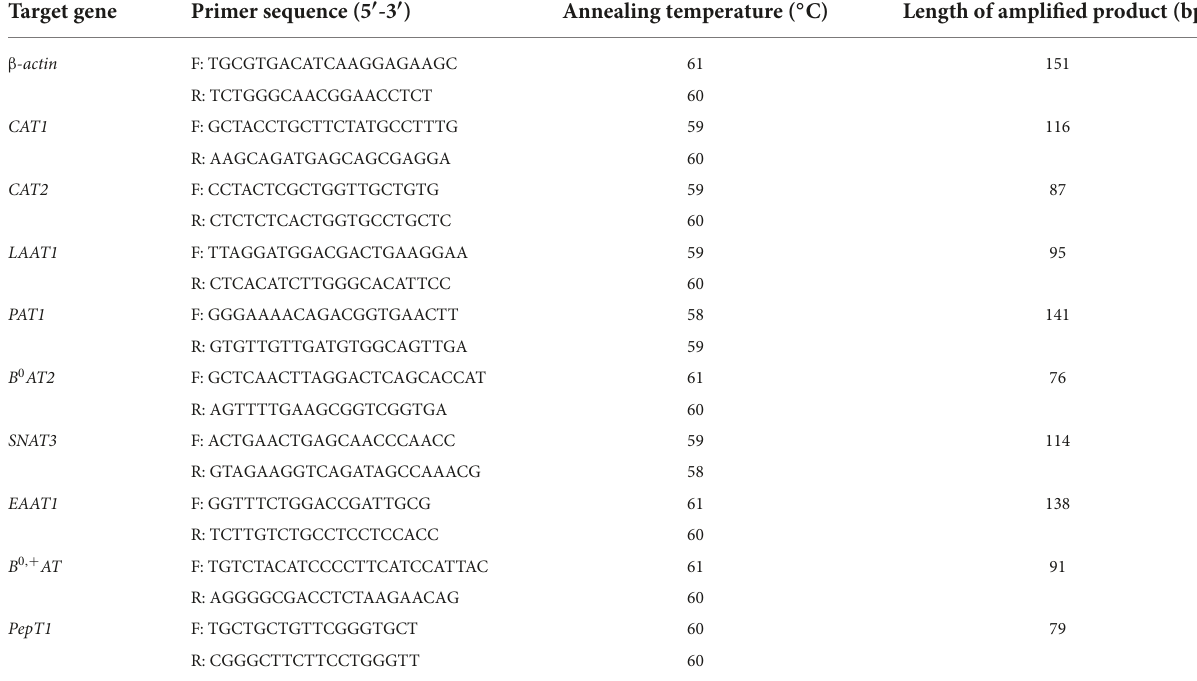
TABLE 2 Sequence of the primers used for quantitative real-time PCR.